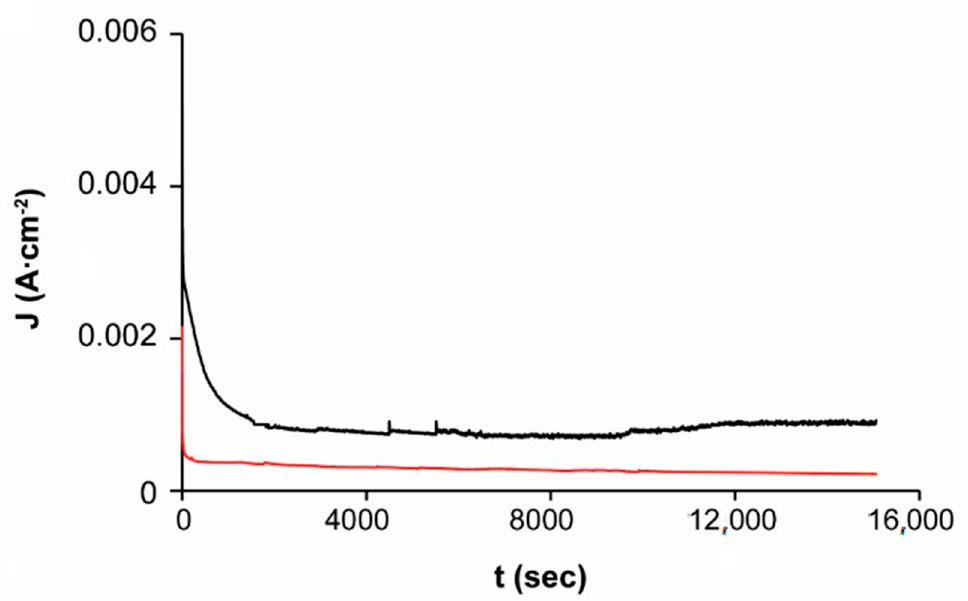
Figure 9. Electrolysis of EBHSS at constant potential E λ + = 1 V vs. SSE of direct current. The red line indicates pH = 7; black line pH = 2.